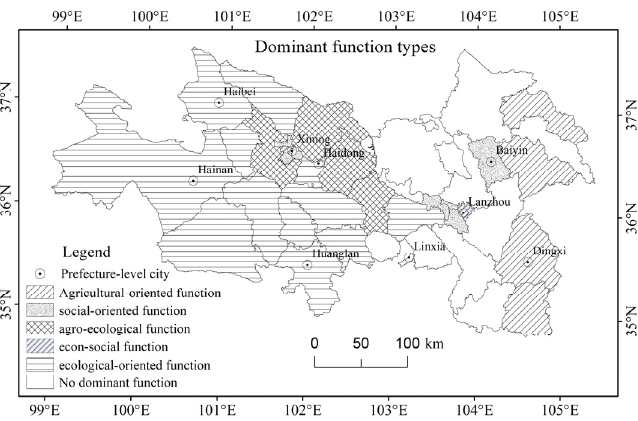
Figure 8. Types of dominant functions.